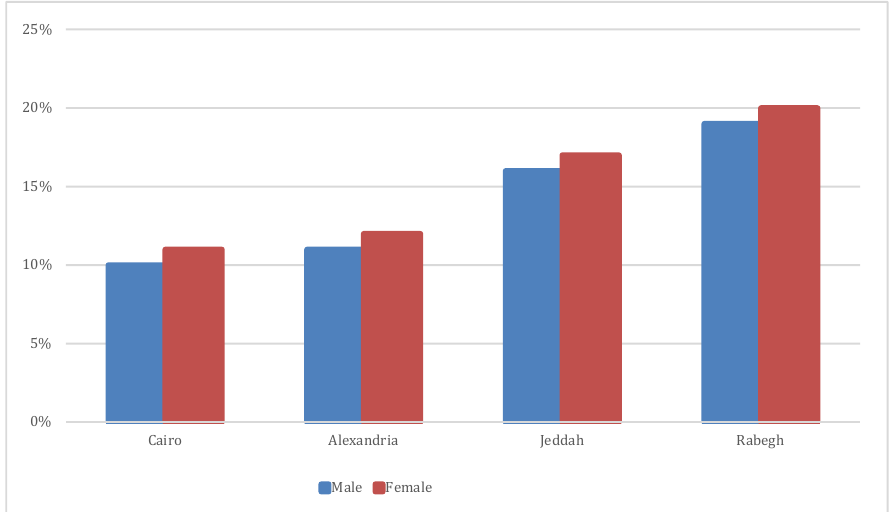
Figure 7. Comparison between males and females according to locality .